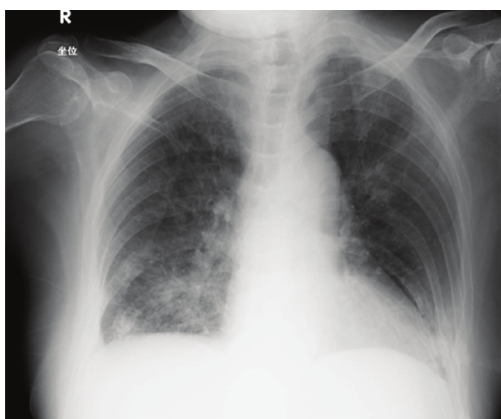
Figure 1: Chest radiograph revealed bilateral ground-glass infil- trates and reticular